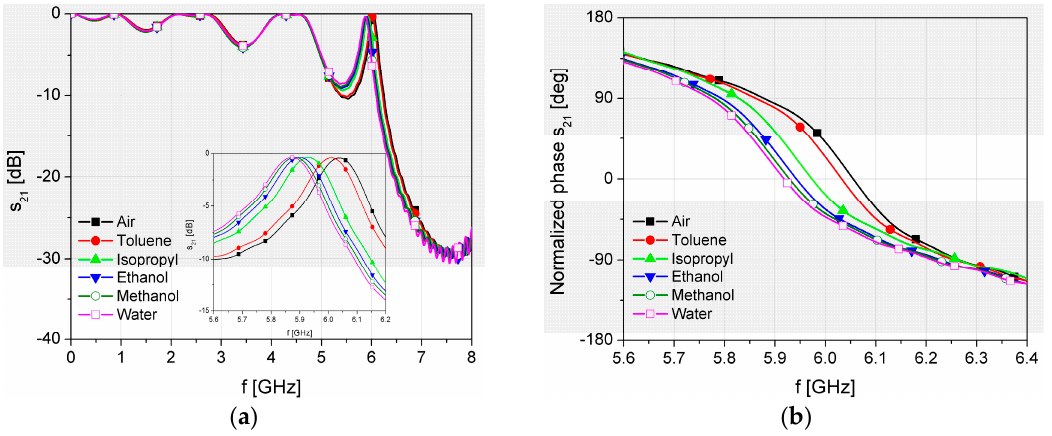
Figure 4. Simulation results of the proposed sensor with different fluids placed in the microchannel: ( a ) transmission characteristic; ( b ) normalized phase. Table 1. Dielectric properties of analysed fluids at room temperature.